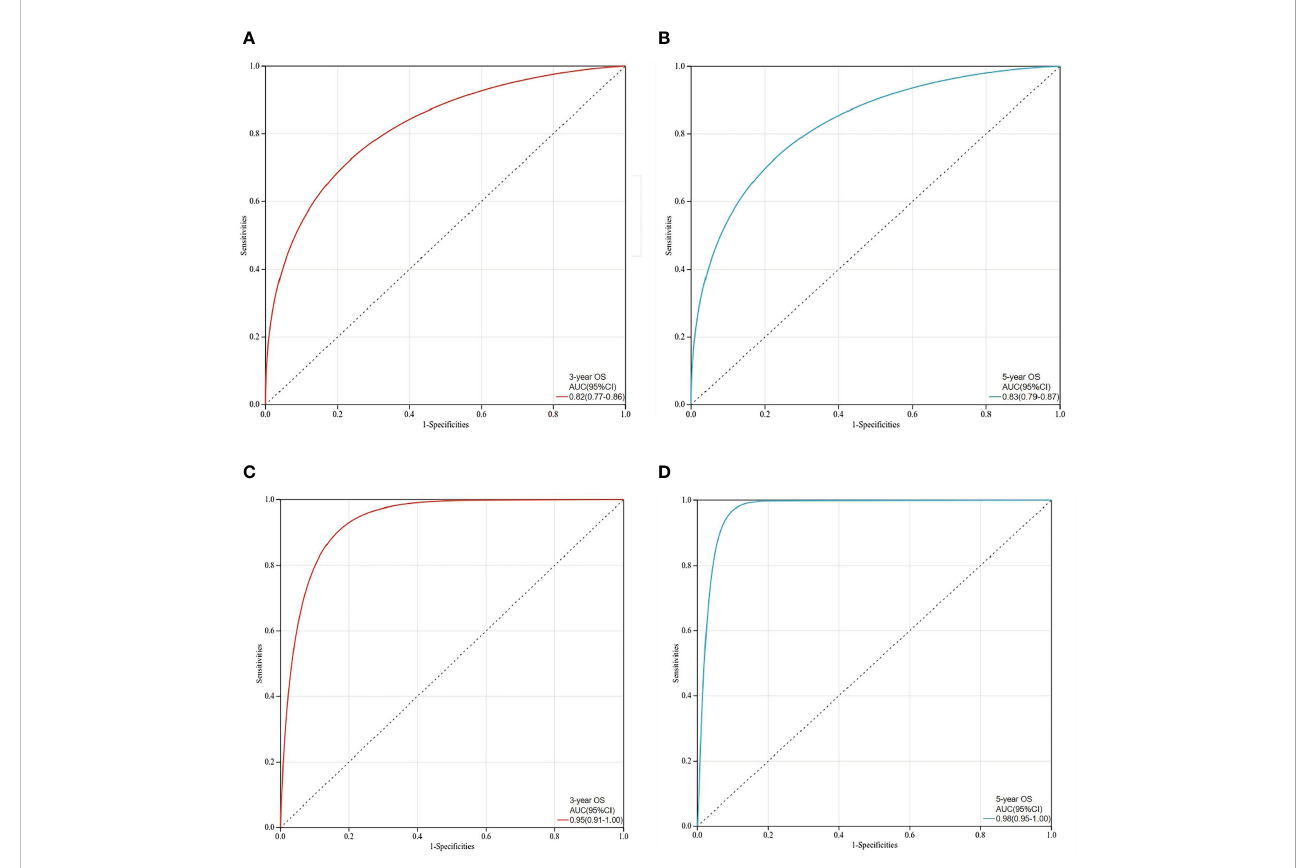
FIGURE 5 ROC curves for prediction of 3-year and 5-year overall survival in the training set and validation set. (A) The 3-year overall survival of the training set; (B) The 5-year overall survival of the training set; (C) The 3-year overall survival of the validation set; (D) The 5-year overall survival in the validation